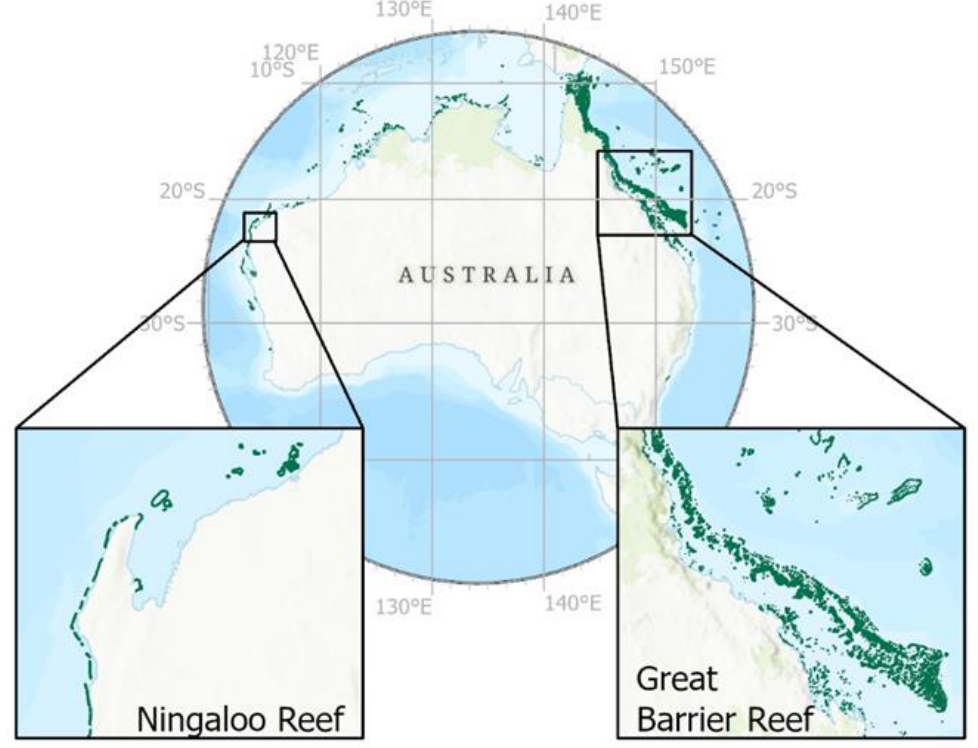
Figure 1. The Ningaloo Reef and the southern Great Barrier Reef study regions in context to Australia. Green polygons denote the location of corals in Australia included in this study.